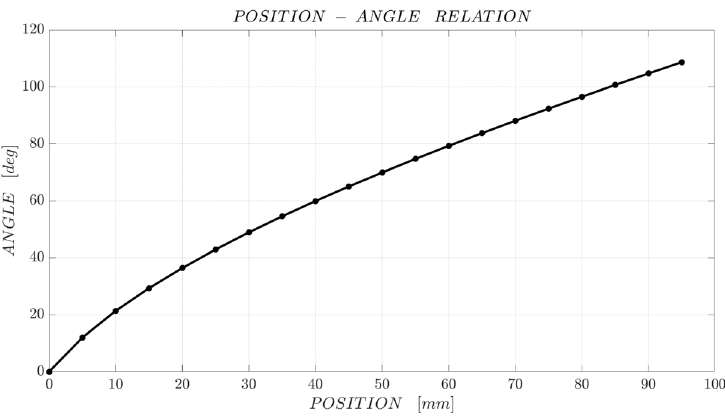
Figure 15. Position angle curve.